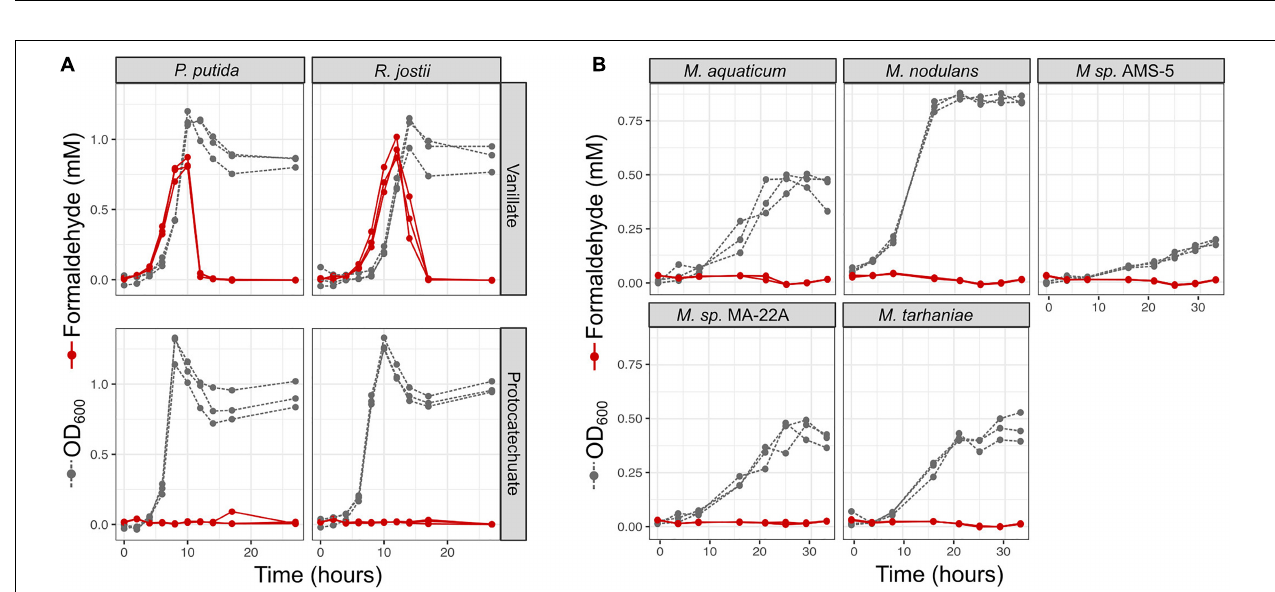
FIGURE 6 | Non-methylotrophic lignin degraders Pseudomonas putida and Rhodococcus jostii produce formaldehyde when growing on methoxy-substituted aromatic compounds such as vanillate; Methylobacterium do not. All organisms were grown in defined mineral medium with vanillate or protocatechuate (PCA) as a sole carbon source; growth was assayed by optical density at 600 nm (gray symbols and dashed lines) and formaldehyde in the medium was measured by a colorimetric assay (red symbols and solid lines). Each line represents one biological replicate. (A) P. putida and R. jostii accumulate formaldehyde transiently in the medium when growing on vanillate, but not on the non-methoxylated compound PCA, and growth is slower on vanillate. (B) All Methylobacterium species tested grew on vanillate without producing measurable formaldehyde. Source data are available in Supplementary Table 6 .